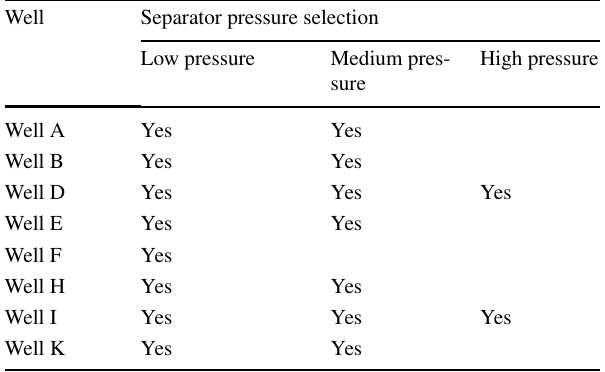
Table 1 Establishing the well connections to the pressure vessels based on their pressures